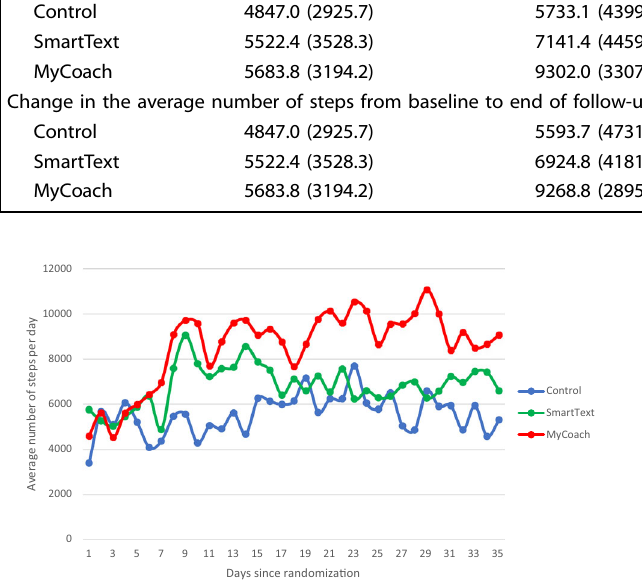
Fig. 1 Average steps per day by groups. Blue line — control. Green line — SmartText. Red line — MyCoach.